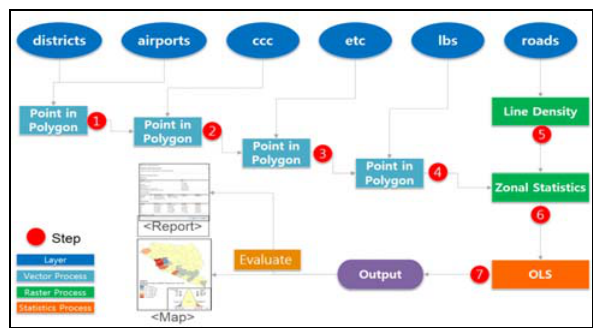
Figure 8. Simplified Workflow of Ebola Predictive